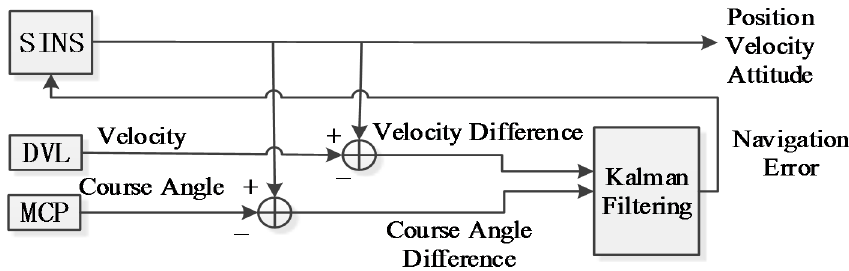
Figure 8. SINS/DVL/MCP integrated navigation system.